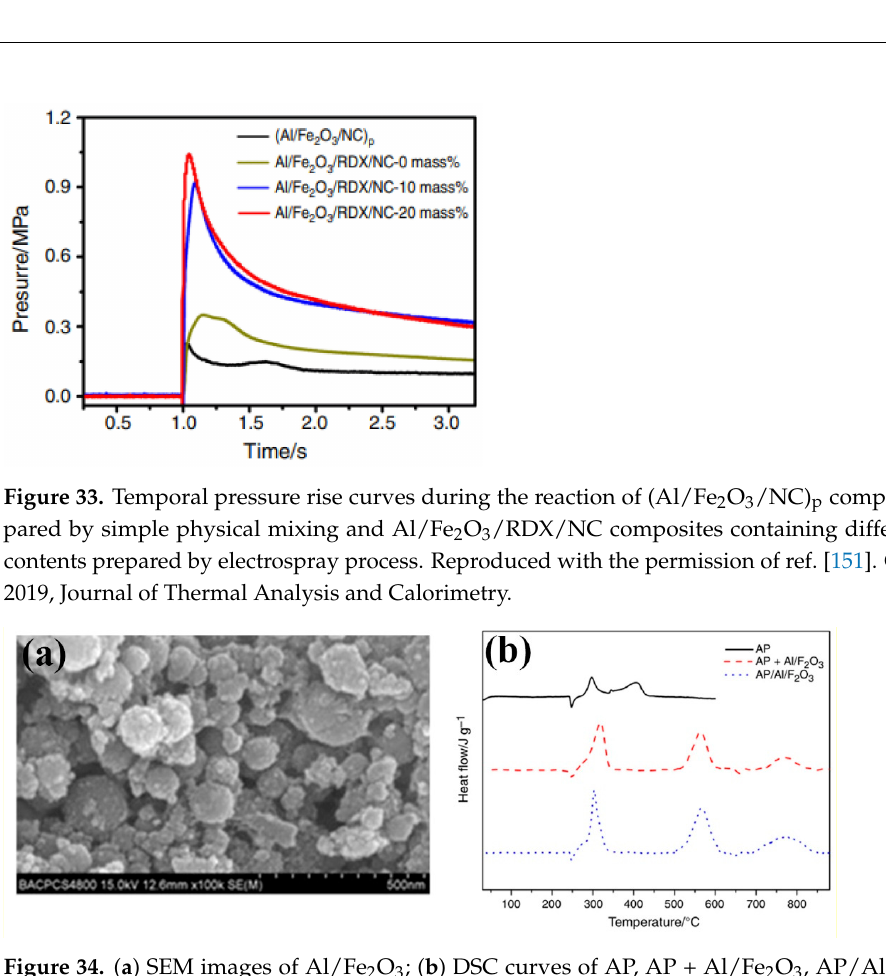
Figure 5-8. ( a ) SEM images of Al/Fe 2 O 3 ; ( b ) DSC curves of AP, AP + Al/Fe 2 O 3 , AP/Al/Fe 2 O 3 at 10 °C·min − 1 . ( a , b ) Reproduced with the permission of ref. [152]. Copyright 2014, Journal of Thermal Analysis and Calorimetry.